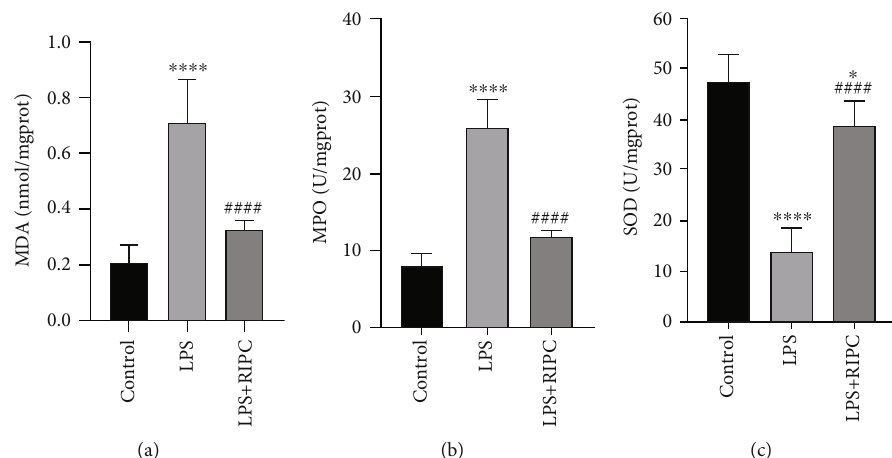
Figure 3: The RInPC palliated the oxidative stress in the lung induced by the LPS. (a) Comparison of MDA between each group. (b) Comparison of MPO between each group. (c) Comparison of SOD between each group. ∗ P < 0 : 05 ; ∗∗∗∗ P < 0 : 0001 vs. control group; #### P < 0 : 0001 vs. LPS group ( n = 6 ). MPO: myeloperoxidase; MDA: malondialdehyde; SOD: superoxide dismutase.